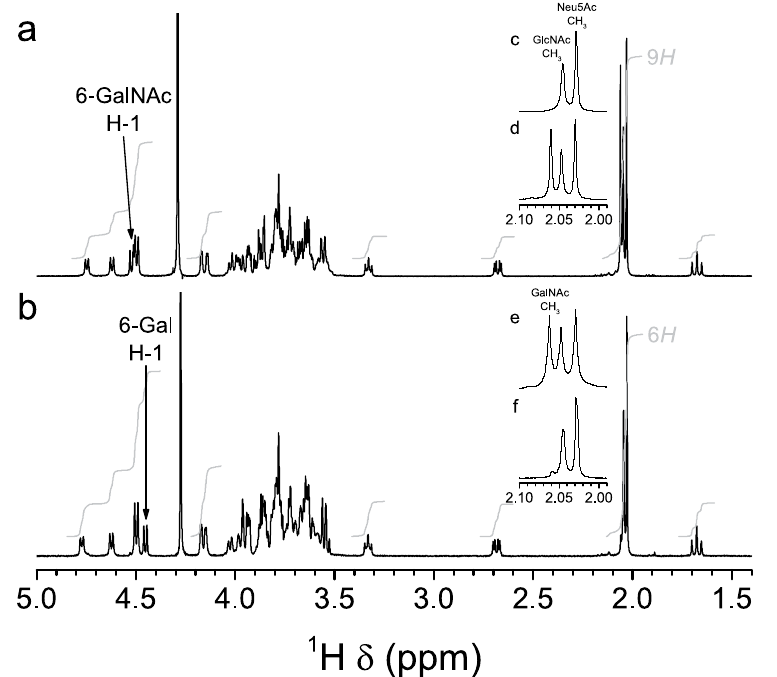
Figure 4. 1D 1 H NMR spectra of CPS preparations from serotypes 14 and 1 in 33 mM phosphate pD 8.0 in D 2 O. ( a , b ) Full spectrum. ( c–f ) Expansion of the methyl region. ( a , d ) SS14to1 mutant, 500 MHz, 75 °C. ( b , f ) SS1to14 mutant, 500 MHz, 77 °C. ( c ) Serotype 14 field strain, 500 MHz, 77 °C 18 . ( e ) Serotype 1 field strain, 700 MHz, 70 °C 19 . Specific characteristics of the 1 H NMR spectrum due to the presence of GalNAc in the native serotype 1 CPS were also found in the spectrum of the CPS from the corresponding mutant expressing serotype 1 CPS. Conversely, the spectrum of the CPS from the mutant expressing serotype 14 CPS, as well as that of the native serotype 14 CPS, lacked the signal attributed to N -acetyl of